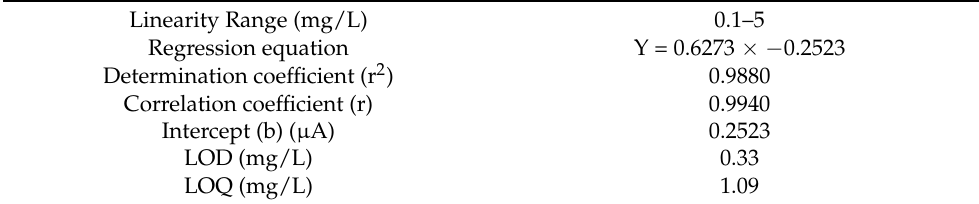
Table 4. Analytical characteristics for the determination of